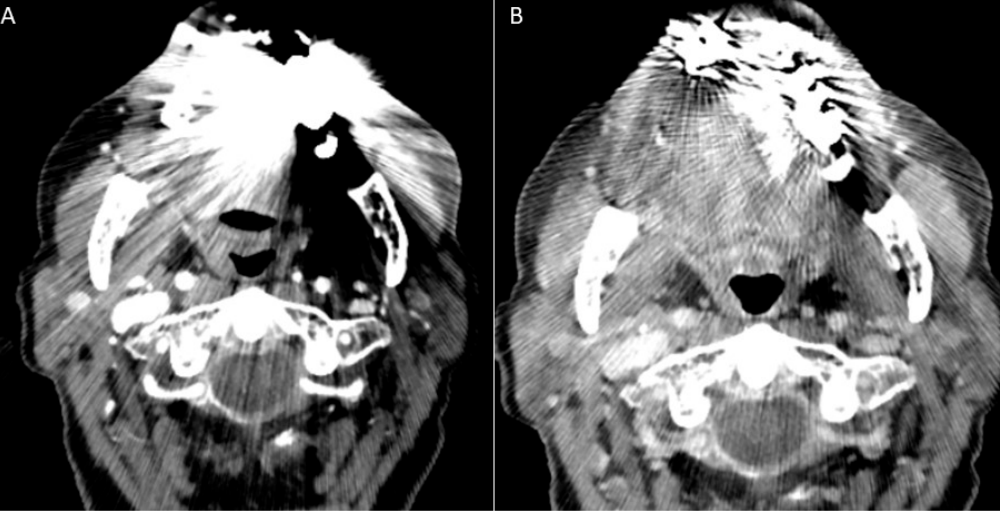
Figure 20. Metal Artifact Reduction Algorithms (MAR). ( A ) Axial contrast-enhanced standard MSCT with photon starvation artifacts. ( B ) Axial contrast-enhanced O-MAR (MAR for orthopaedic implants; Philips. the Netherlands) MSCT of the same patient. A better visualisation of the oral cav- data points identified as metal with interpolated